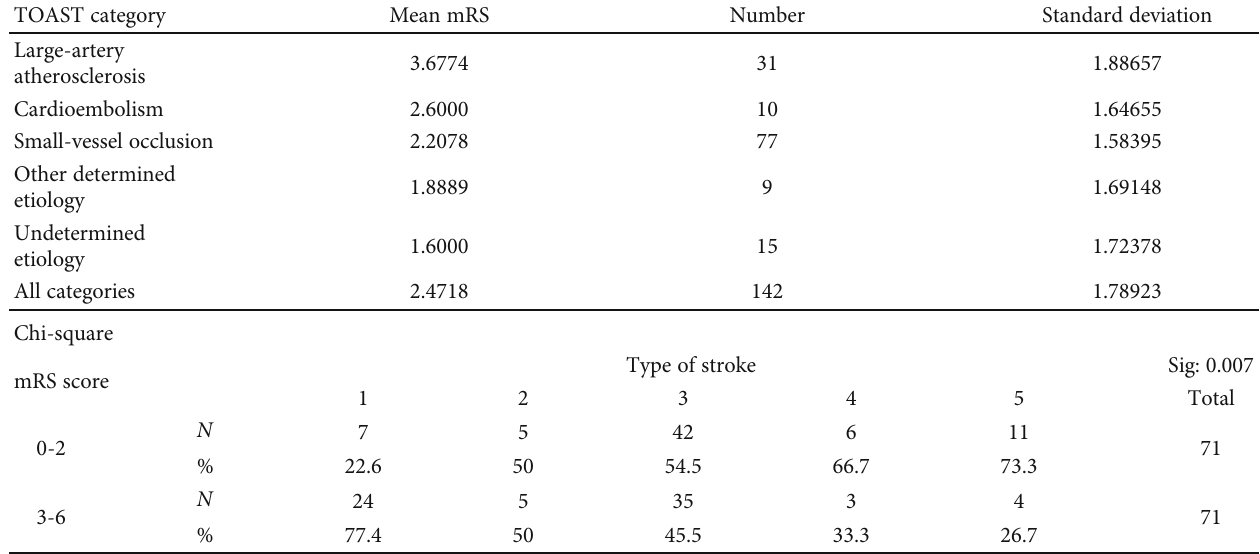
Table 6: Mean mRS score for each stroke etiology and the correlation between stroke etiology and mRS scores.